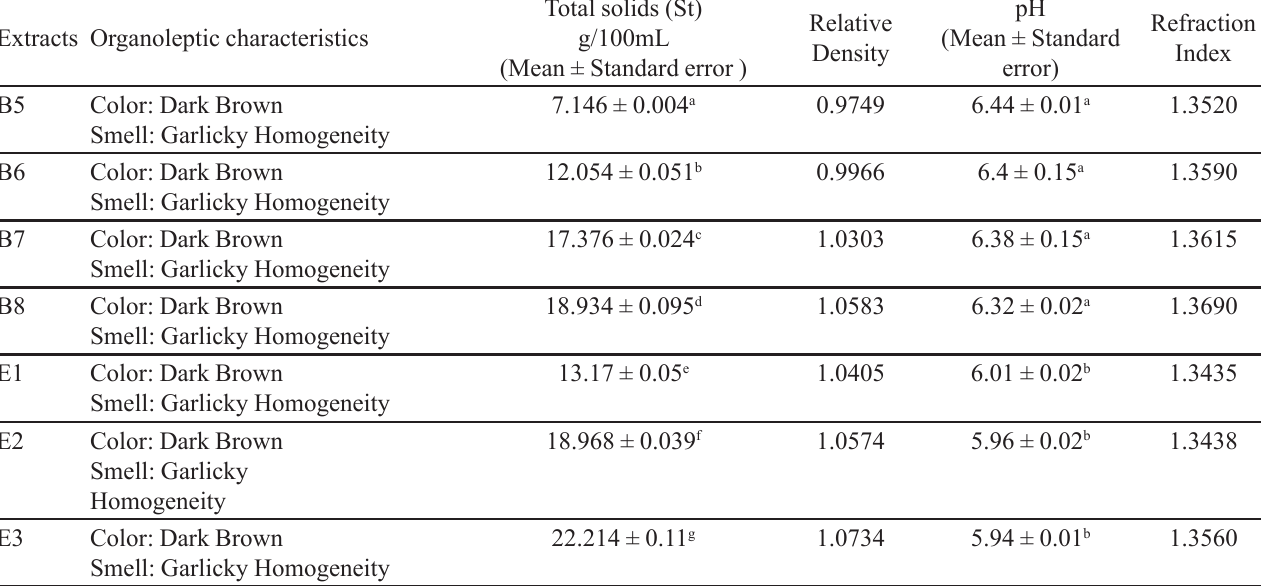
TABLE III - Average results of the physical and physical-chemical quality control of some extracts